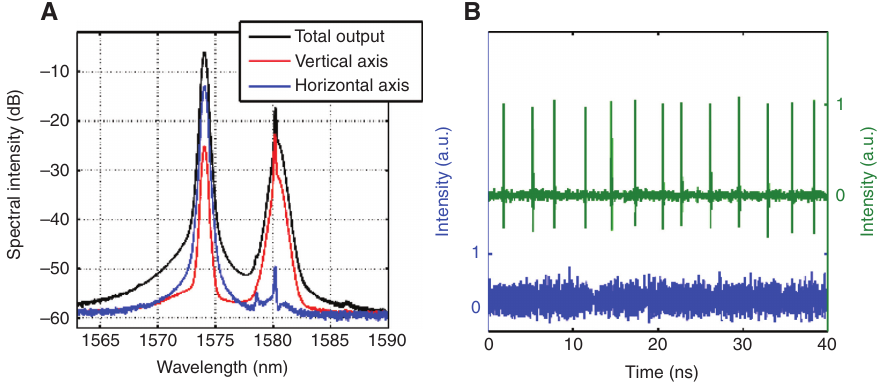
Figure 4: Dual-wavelength operation of the gain-guided dissipative soliton fiber laser: continuous wave and scalar gain-guided dissipative